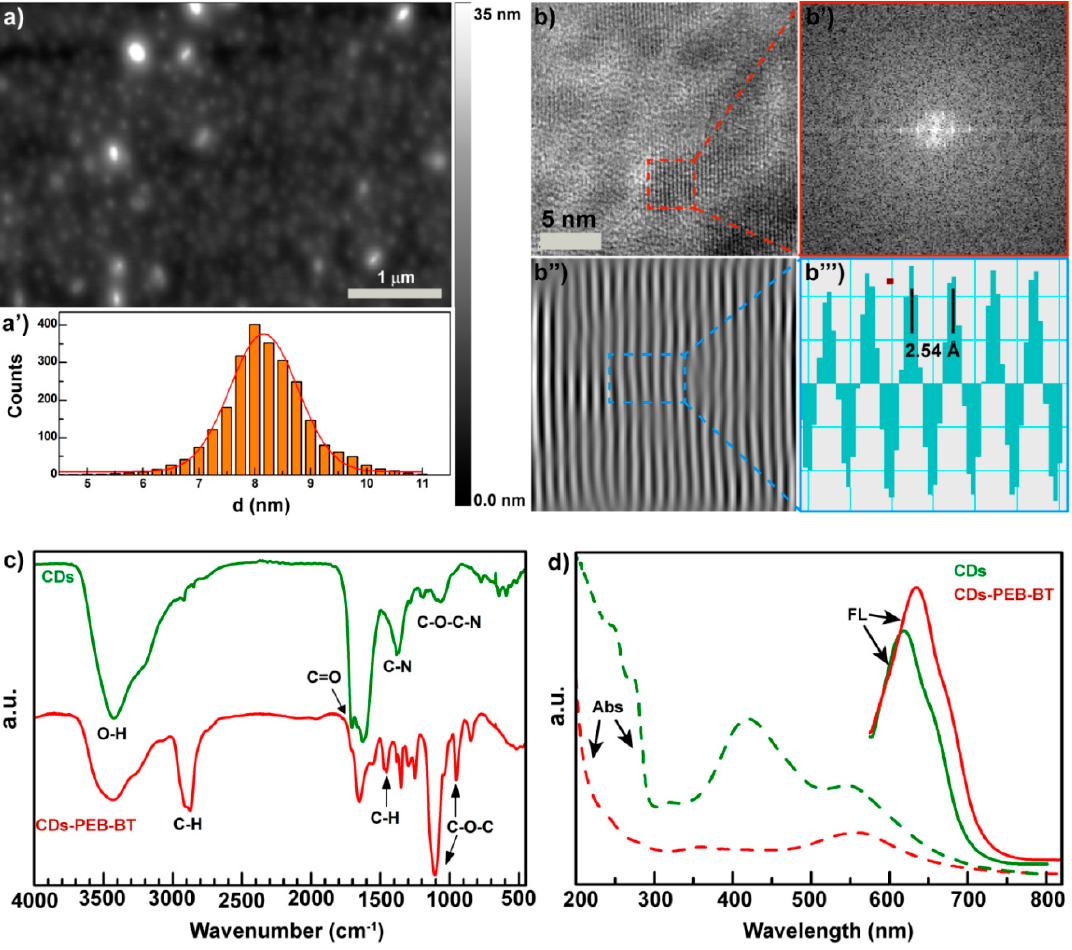
Figure 2. Physicochemical characterization of the CDs-PEG-BT. Atomic force microscopy (AFM micrograph ( a ) and size distribution ( a’ ) of the CDs-PEG-BT. HRTEM micrograph ( b ), fast Fourier transform (FFT) ( b’ ), inverse fast Fourier transform (IFFT) ( b’’ ), and d-spacing calculation ( b’’’ ) of the